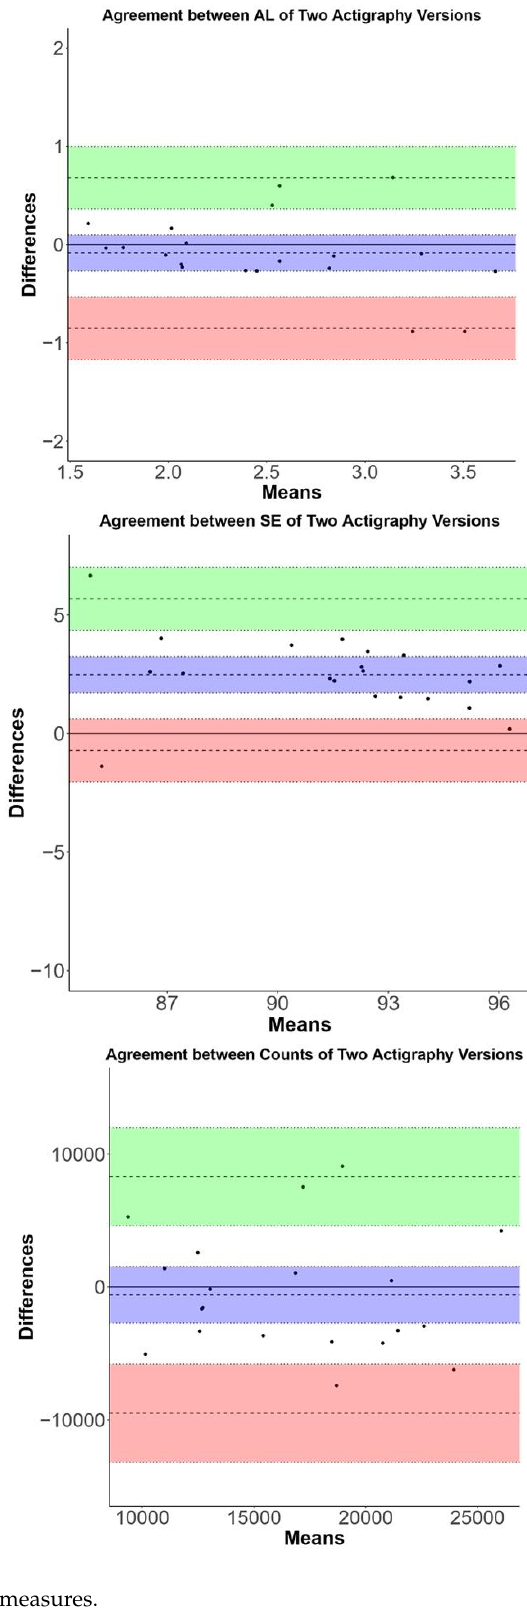
Opal Actigraphy and ActiLife solution (ActiGraph GT3X and GT9X) generated activ- ity counts, activity intensity levels, and sleep measures during daily life. Comparisons